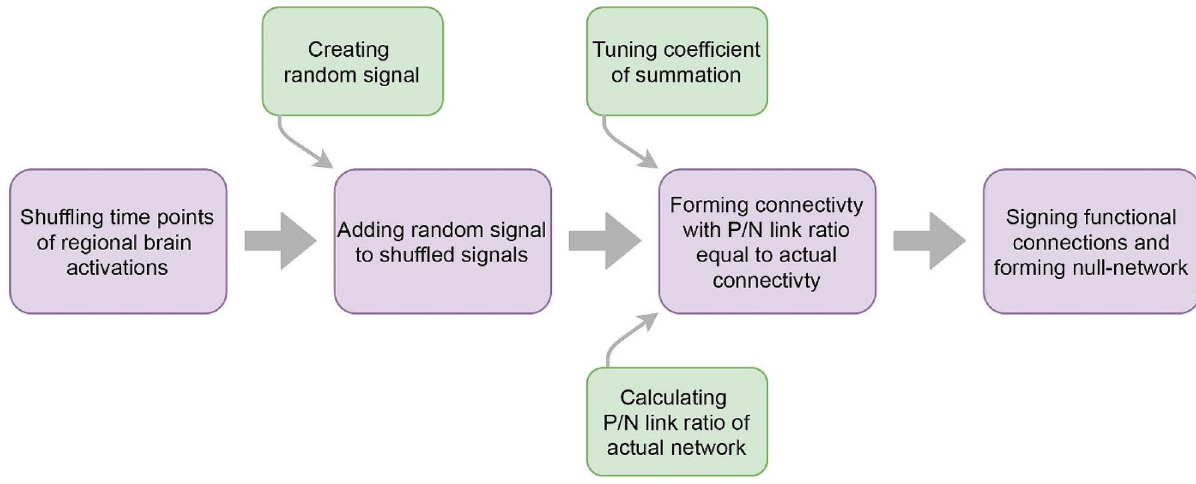
Figure 9. Procedure of null-network